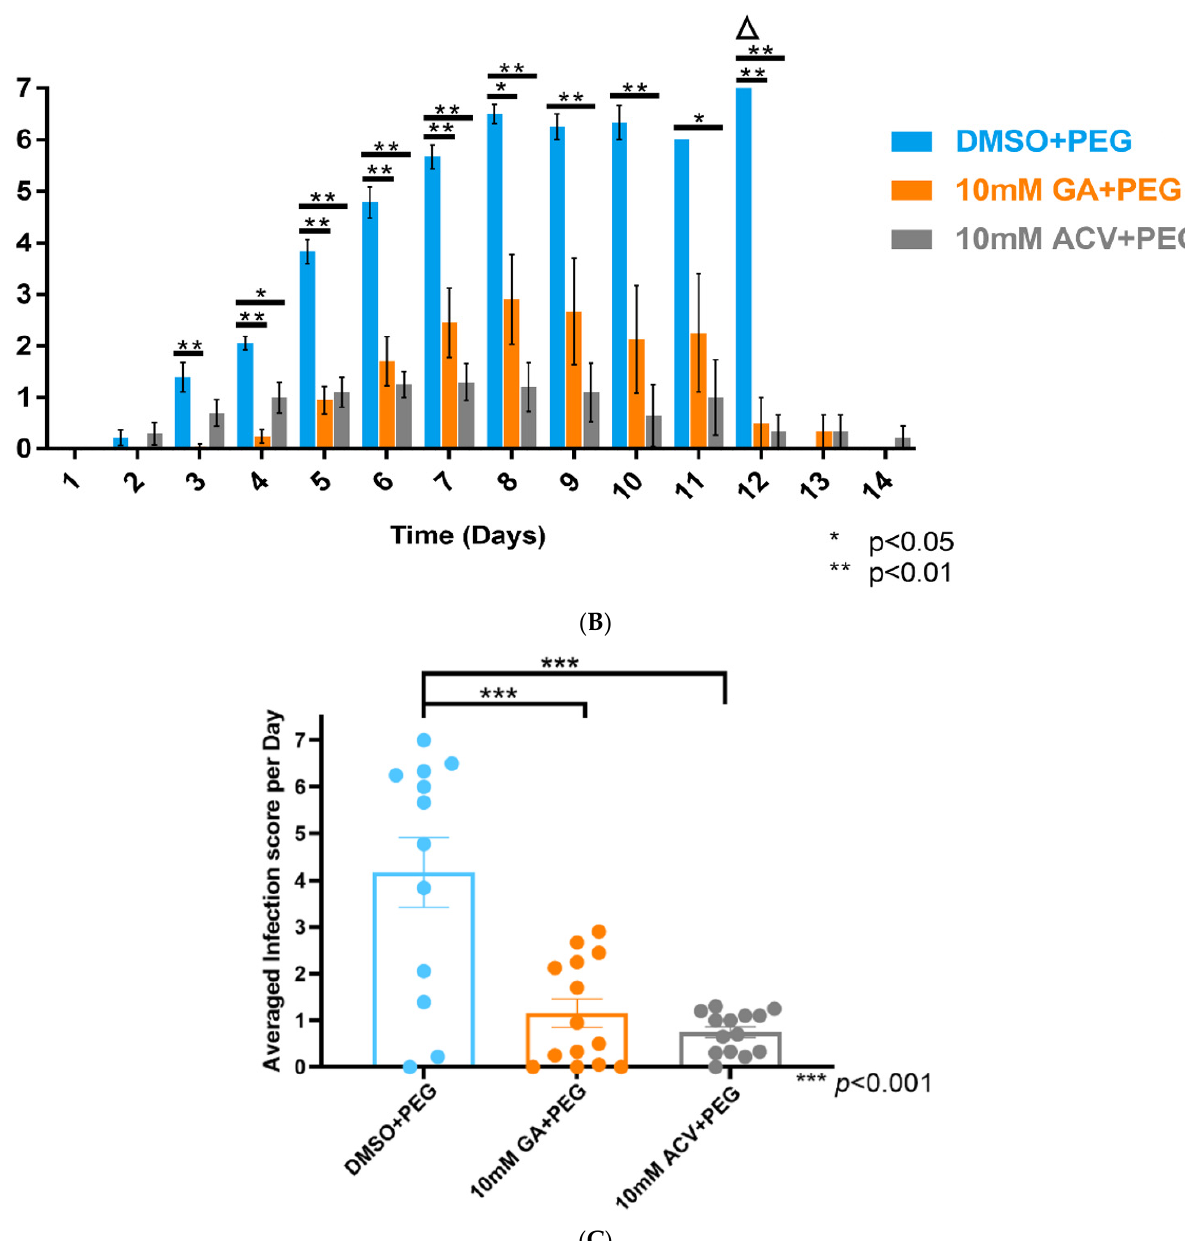
Figure 3. GFP-HSV-1 average zosteriform infection scores of BALB/cJ mice, following the application of 10% vehicle-DMSO in Polyethylene glycol (PEG) (N = 9/group), 10 mM GA in PEG (N = 10/group), and 10 mM Acyclovir in PEG (N = 10/group). ( A ) Age-matched BALB/cJ mice were inoculated with 6 × 10 4 PFU of GFP-HSV-1, given respective treatments, and monitored for survival for 14 days. ( B ) Averaged infection scores of surviving animals in each treatment group across 14 days. ( C ) Combined infection score of all animals, in their respective groups, per day for 14 days. Student independent t -tests (2-tailed); * p < 0.05; ** p < 0.01; *** p < 0.001. Δ indicates that all DMSO-treated animals died on day 12. All error bars represent SEM.